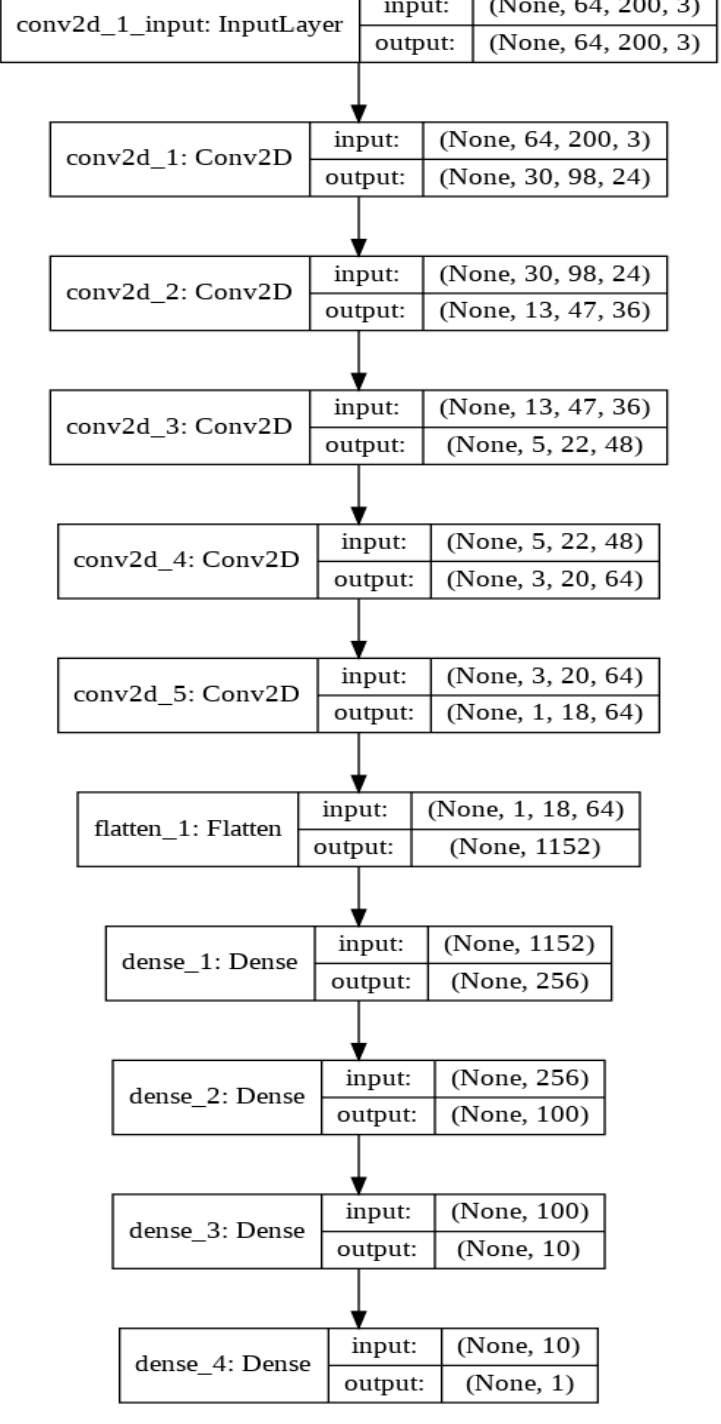
Figure 18. Experimented with Nvidia CNN architecture.